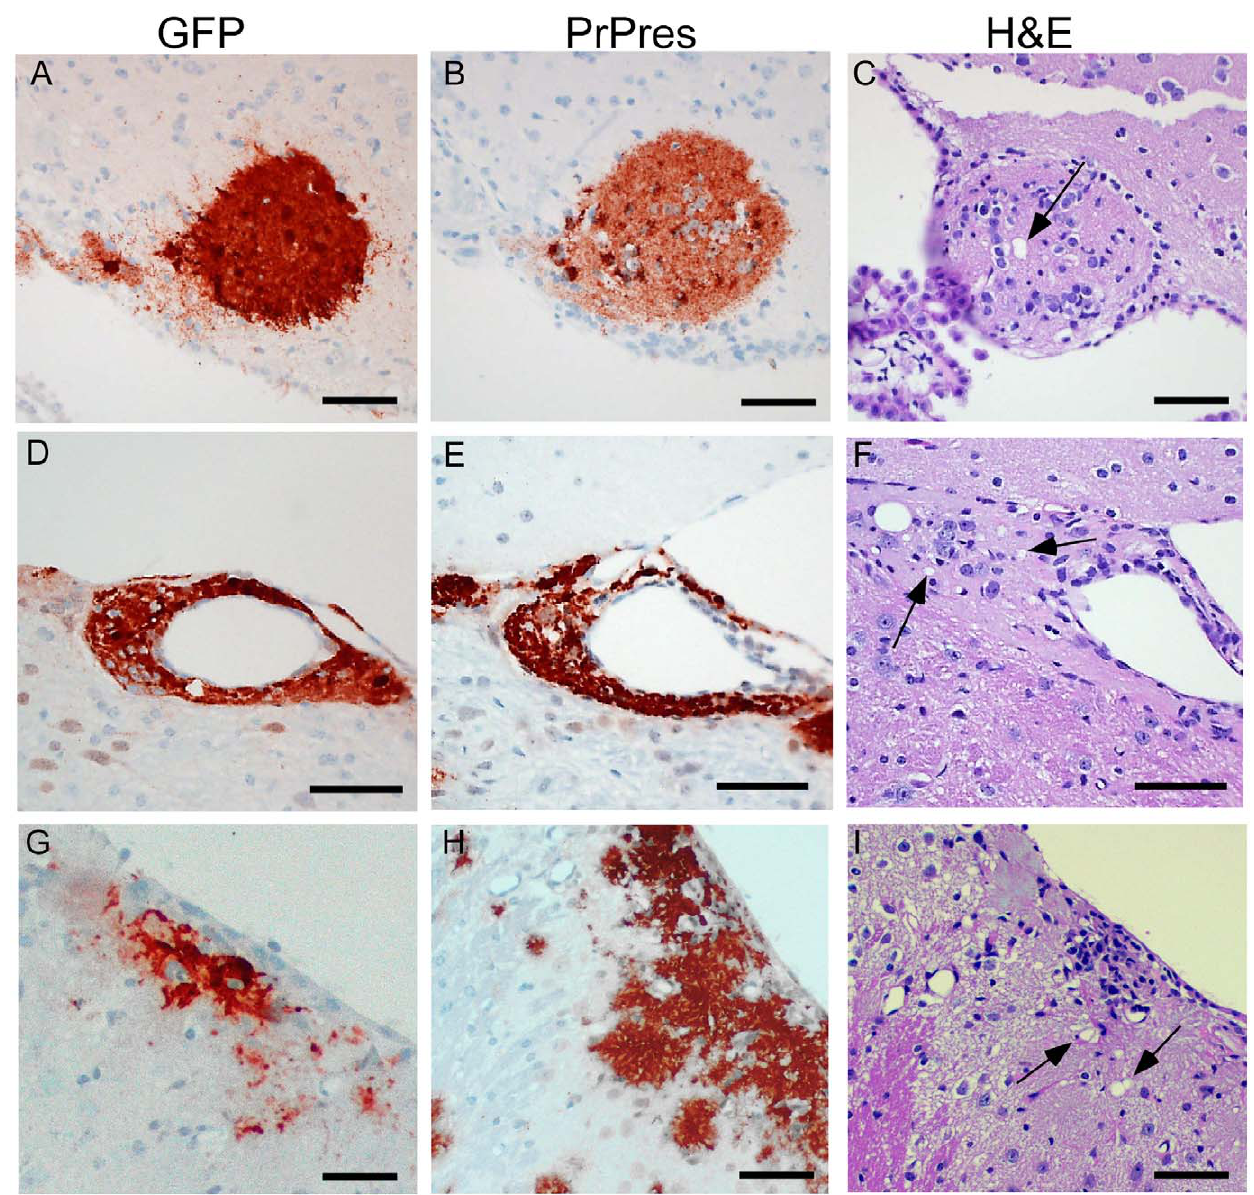
Figure 7. Detection of PrPres and vacuolation in brain tissue of PrPnull and tg44 + / 2 mice with C57BL/6 brain grafts. Grafts expressed green fluorescent protein (GFP), and mice were infected IC with 22L scrapie approximately 5 weeks after grafting. Panels A–C, PrPnull recipient at 261 dpi; Panels D–F, tg44 + / 2 recipient at 261 dpi; Panels G–I, tg44 + / 2 recipient at 200 dpi. Panels A, D, G show staining with anti- GFP which detects constitutive GFP expression in the C57BL/6 donor tissue. Panels B, E, H show D13 staining of PrPres. Panels C, F, I show H&E staining to detect scrapie-induced vacuoles indicated by arrows.